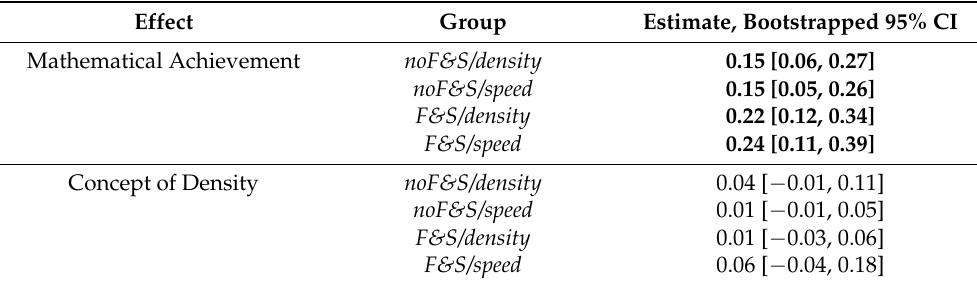
Table 5. Indirect effects in mediation model per group in Study